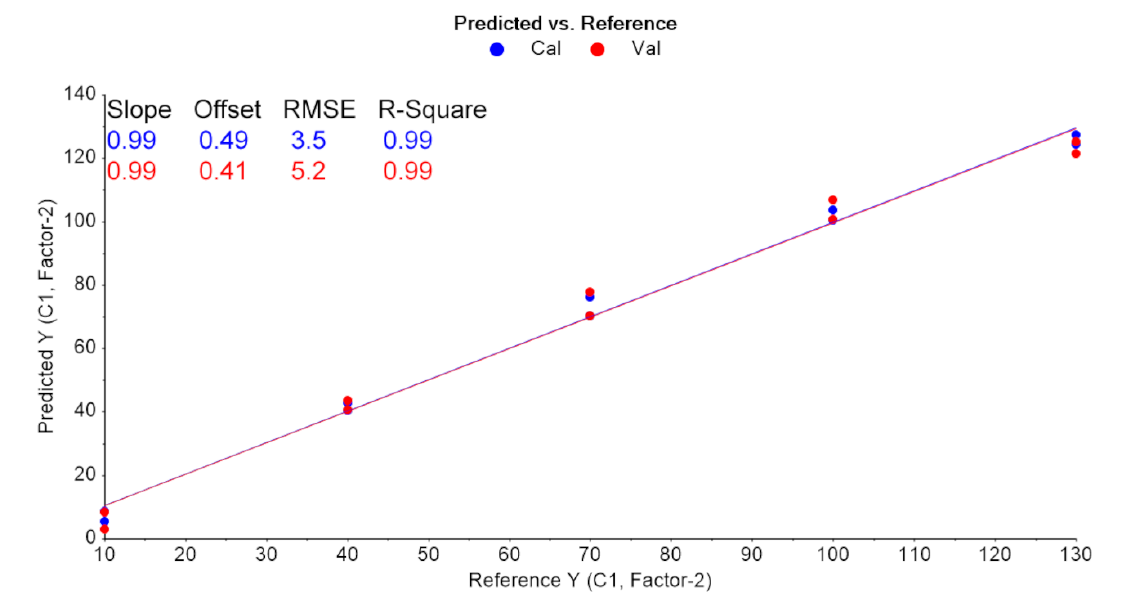
Figure 4. Scores plot of the training set (blue: 1 g/L, red: 4 g/L, green: 7 g/L, cyan: 10 g/L, brown: 13 g/L of DS). Each point corresponds to a different control batch consisting of three spectra for each concentration (N total = 30 spectra).